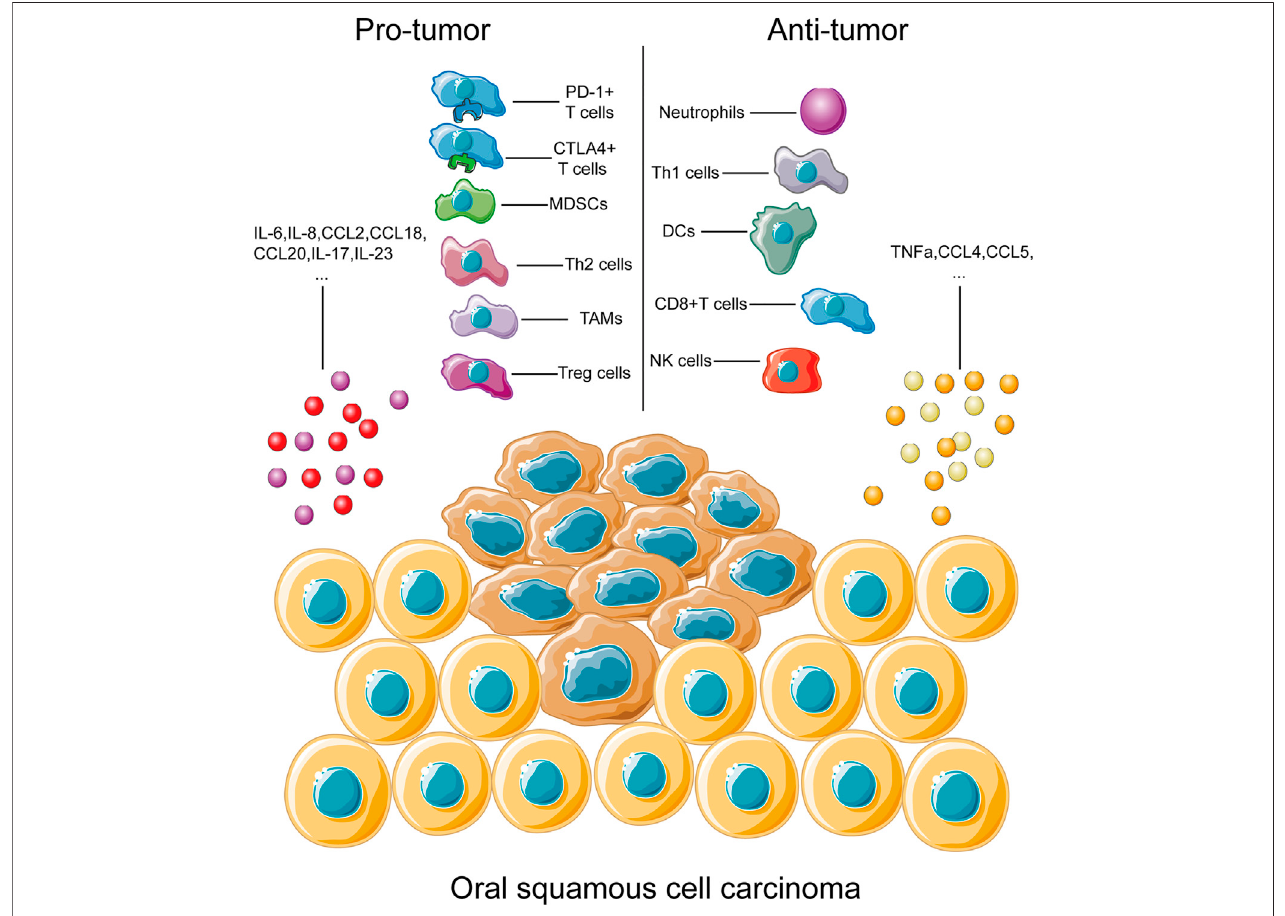
FIGURE 1 | Immune cells and cytokines associated with OSCC progression. This fi gure depicts the main types of immune cells and cytokines associated with progression of OSCC development. During OSCC progression, immune cells and cytokines could be divided into two groups, the pro-tumor part and the anti-tumor part. Immune cells, including PD-1 + and CTLA4 + T cells and TAMs, have been identi fi ed to play roles in tumor progression through multiple pathways, as discussed above. Similarly, immune cells contributing to the anti-tumor process, Th1 cells and NK cells, for example, were also listed inside. A complete overview of immune cells involved in tumor development would help us better understand the complexity of immune regulation of